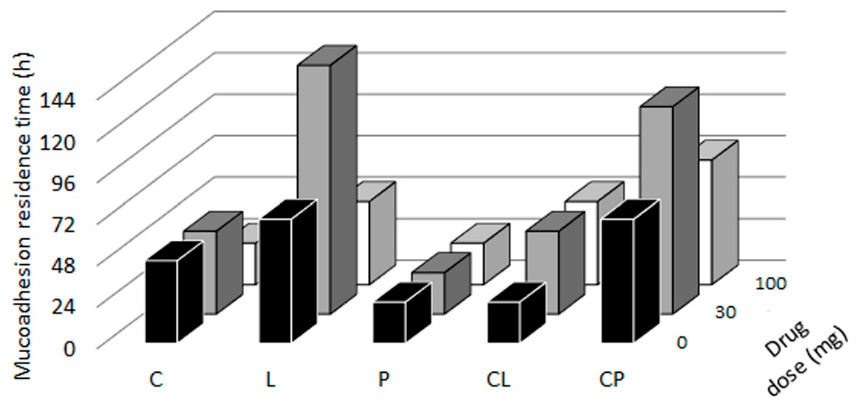
Table 5. Results of the ANOVA processing of the mucoadhesion times of the batches; the factors are the nature of the polymer and the drug content. p -values below α = 0.05 indicate no significant differences.